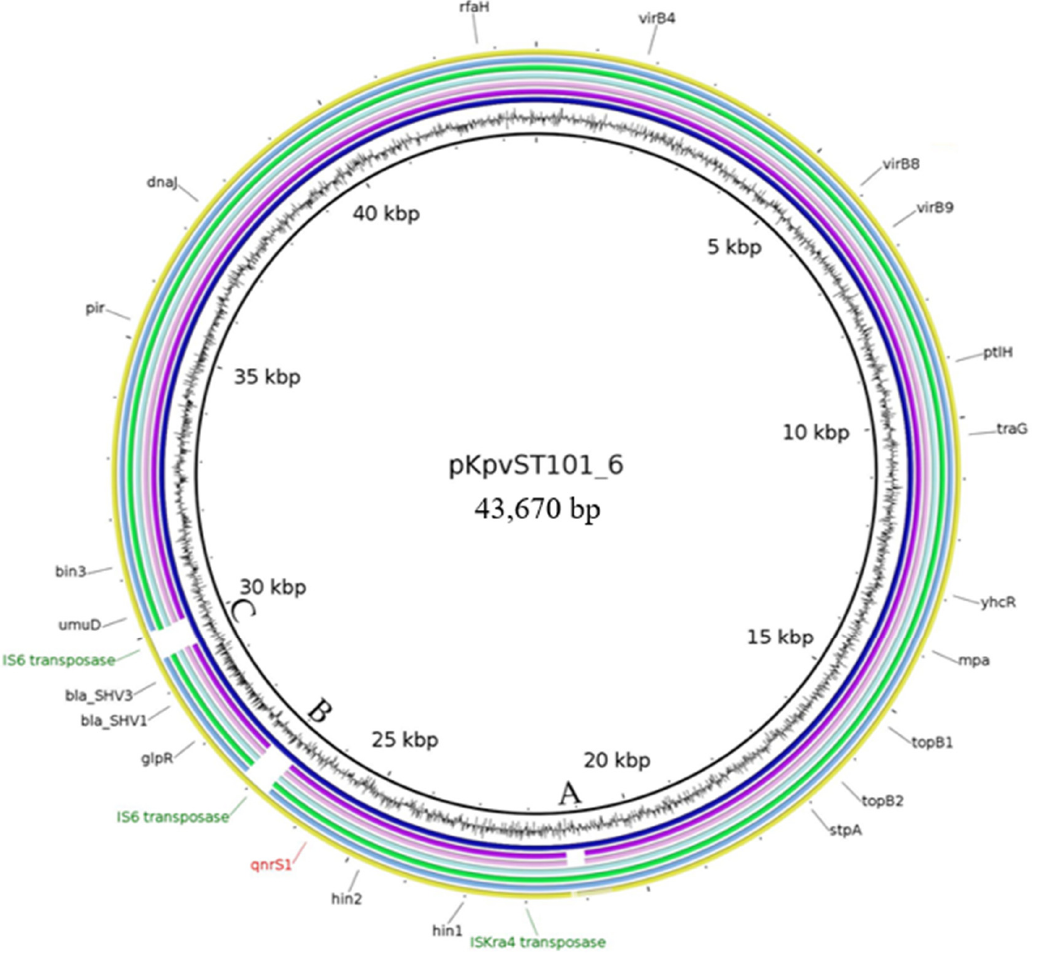
Figure 2. BRIG image of sequence contigs of individual isolates assigned to the reference plasmid pKpvST101_6 (NZ_CP031373). Contigs belonging to the isolates as indicated (from inner to outer ring): pKpvST101_6, 17-AB01005, 17-AB01006, 17-AB01018, 17-AB01798, 17-AB02071 and 17-AB02673. Regions lacking within the investigated are indicated by the capital letters A, B and C.